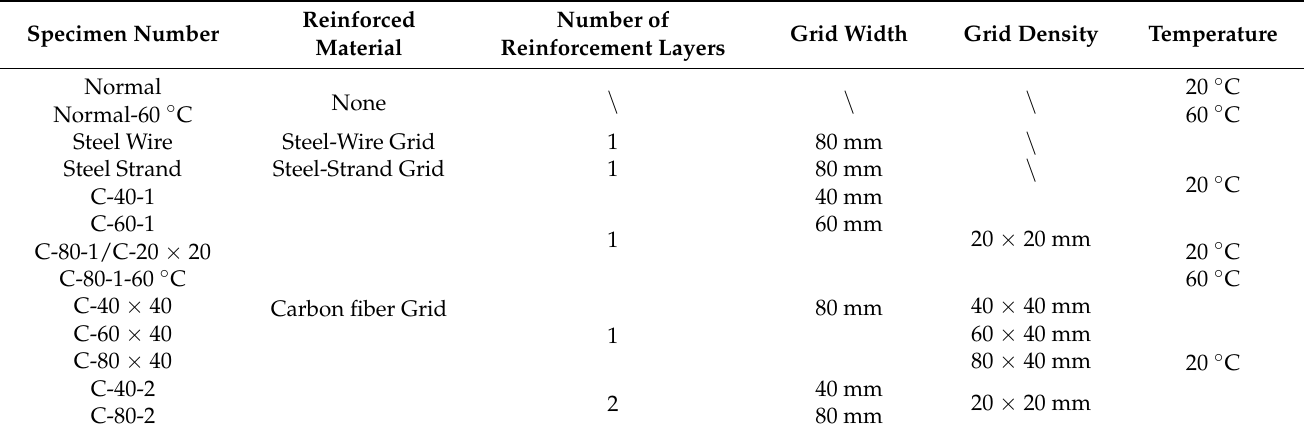
Table 6. Properties of the